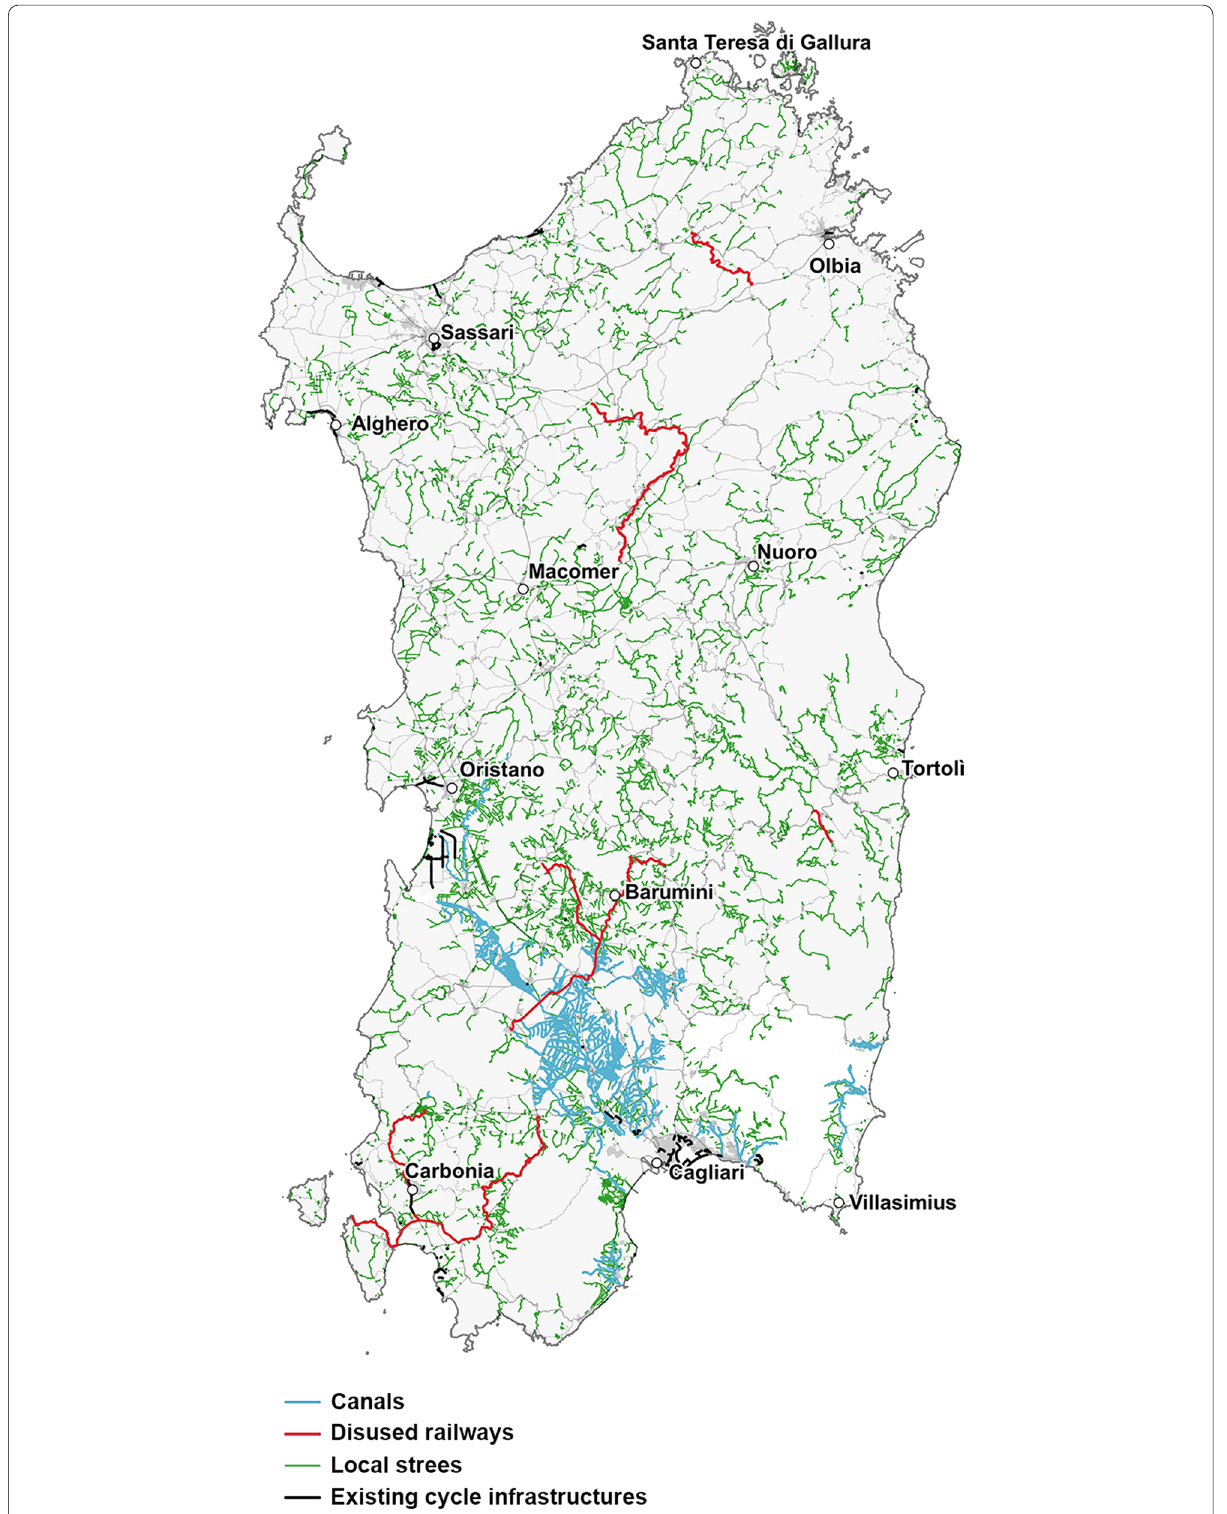
Fig. 3 Existing infrastructure suitable for